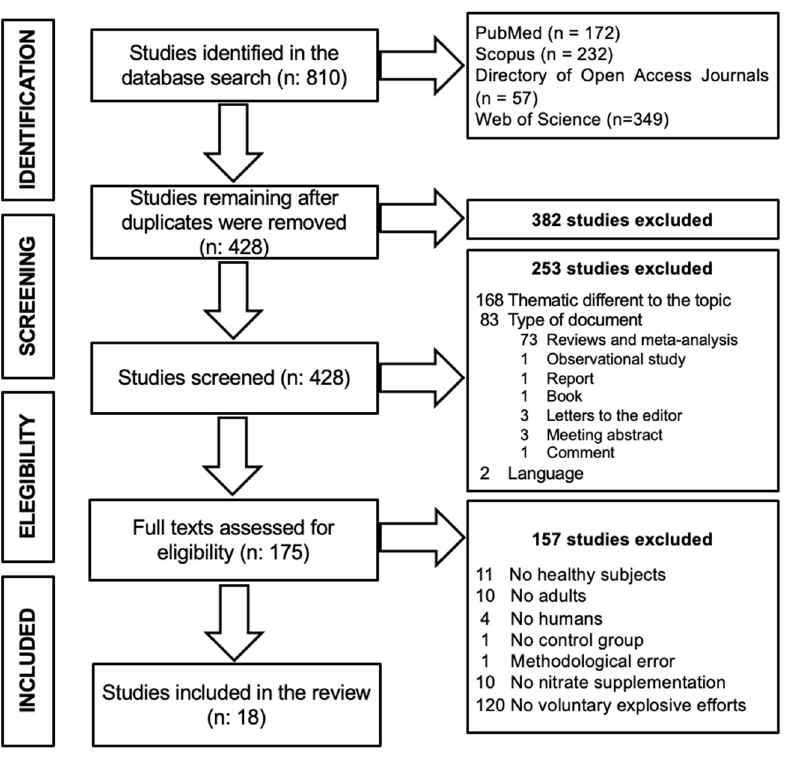
Figure 2. Preferred Reporting Items for Systematic Reviews and Meta-Analysis (PRISMA) flowchart [58].